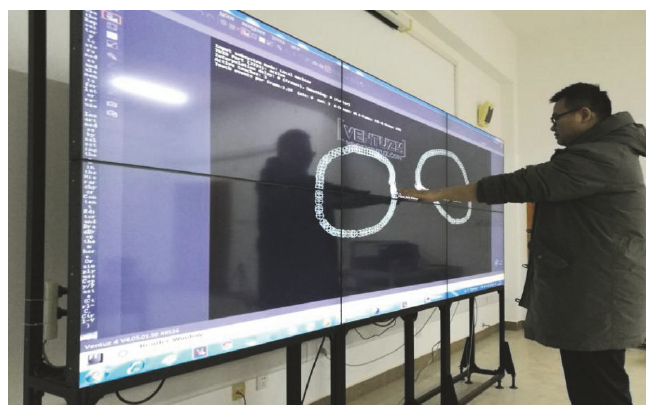
Figure 9: The hands gesture tracking effect based on switching federated filter